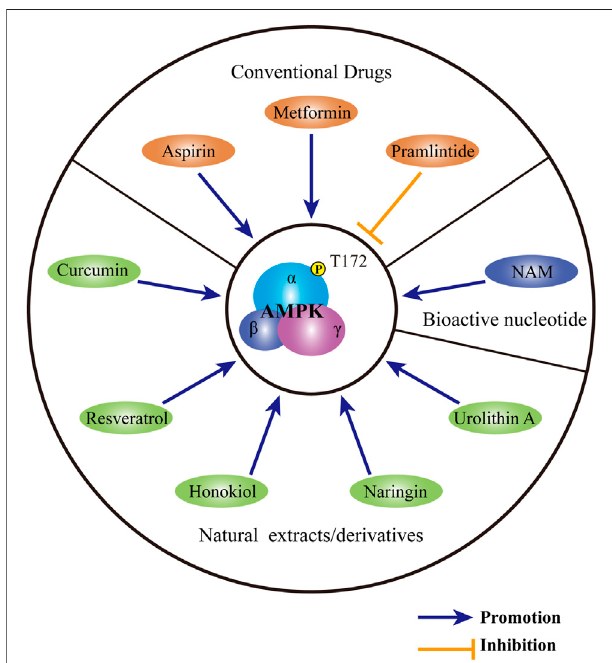
FIGURE 4 | Substances targeting AMPK for the treatment of IDD. Conventional medicines, including metformin, pramlintide and aspirin, show therapeutic potential for IDD through regulating AMPK activity. A variety of natural extracts or derivatives, including curcumin, resveratrol, honokiol, naringin and urolithin A may activate AMPK to provide protection for IVD. As a bioactive nucleotide, NAM may ameliorate the progression of IDD by the modulation of AMPK. AMPK: AMP-activated protein kinase; IDD: intervertebral disc degeneration; NAM: nicotinamide mononucleotide.